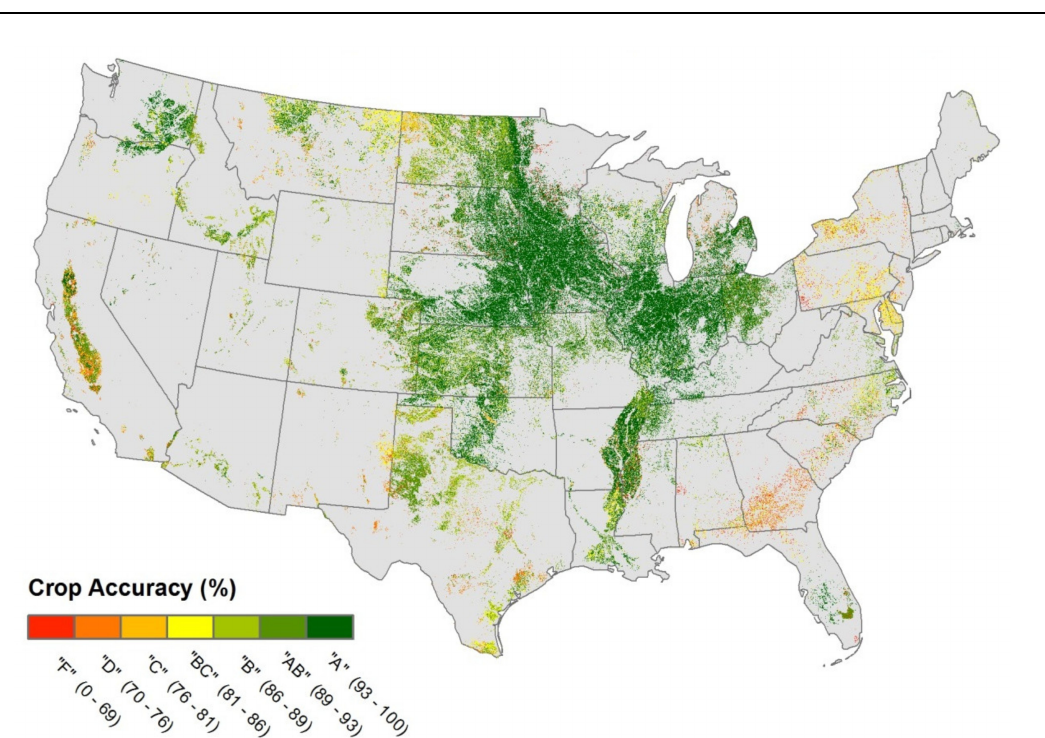
Figure A1. Map of 2012 state level user’s accuracies for specific crop classes of the CDL for the conterminous U.S. Data from USDA NASS (2016) based on the comparison of CDL with FSA reference data for crop classes. An arbitrary grading scale of “A”–“F” was assigned to accuracy intervals to help users easily identify where the CDL crop map excels versus where additional caution may be